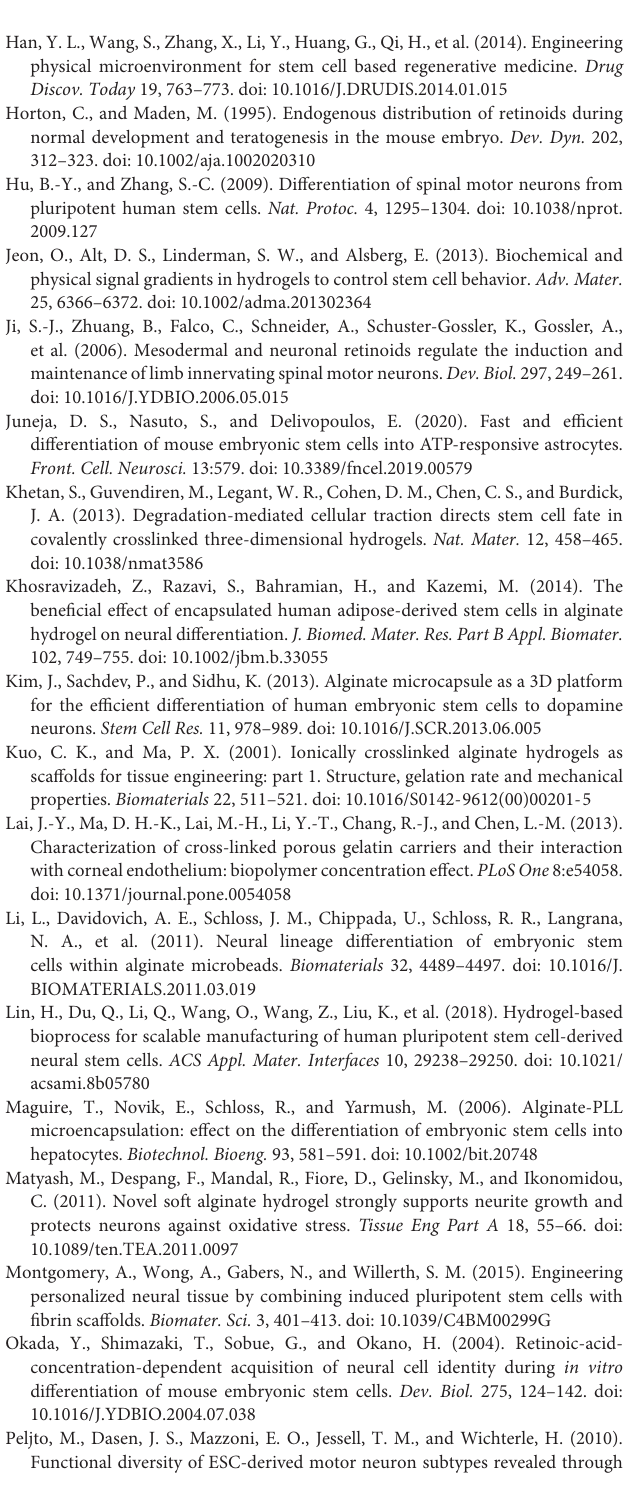
Supplementary Table 1 | Details of antibodies used for immunocytochemistry experiments. Supplementary Table 2 | Product details for LMW and HMW alginate solutions.